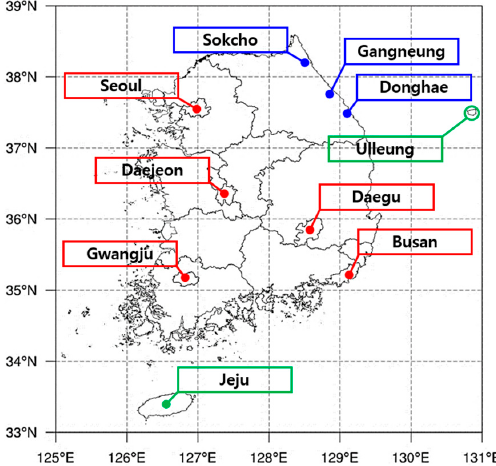
Figure 15. Metropolitan, Yeongdong, and island region cities for studying energy budgets by region in the Korean Peninsula.